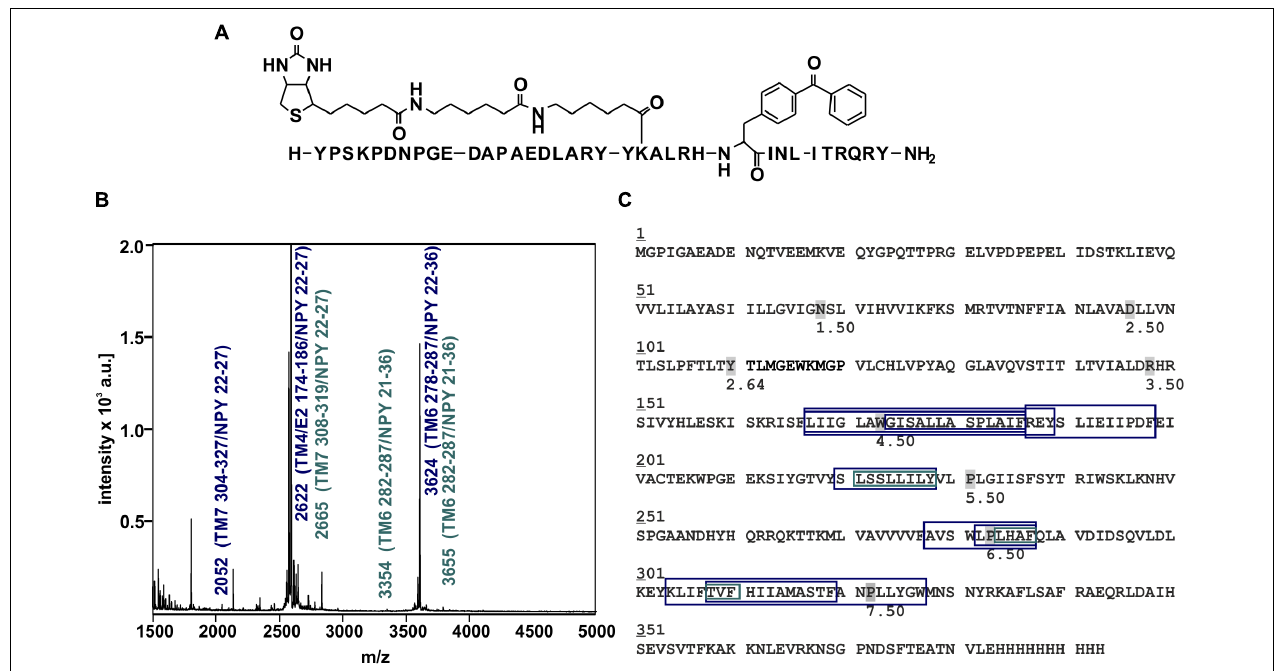
FIGURE 6 | Mass spectra of photo-crosslinked Y 2 R_cysteine_deficient with [K 22 [(Ahx) 2 -biotin]Bpa 27 ]NPY and respective regions of NPY at Y 2 R_cysteine_deficient. (A) Structure of [K 22 [(Ahx) 2 -biotin]Bpa 27 ]NPY. (B) Exemplary MALDI-ToF mass spectrum of photo-crosslinked samples enzymatically digested with chymotrypsin. Potential Y 2 R_cysteine_deficient fragments photo-crosslinked with [K 22 [(Ahx) 2 -biotin]Bpa 27 ]NPY are labeled in blue, fragments which were analyzed by tandem MS are labeled in cyan. TM, transmembrane helix; E, ECL; NPY, [K 22 [(Ahx) 2 -biotin]Bpa 27 ]NPY. (C) Amino acid sequence of Y 2 R_cysteine_deficient with C-terminal deca-histidine-tag. The detected regions of Y 2 R_cysteine_deficient after crosslinking with [K 22 [(Ahx) 2 -biotin]Bpa 27 ]NPY are marked with boxes (blue). Regions analyzed by MS/MS are emphasized by cyan boxes. The different sizes of the boxes represent different detected fragments. All experiments were repeated at least two times, independently.